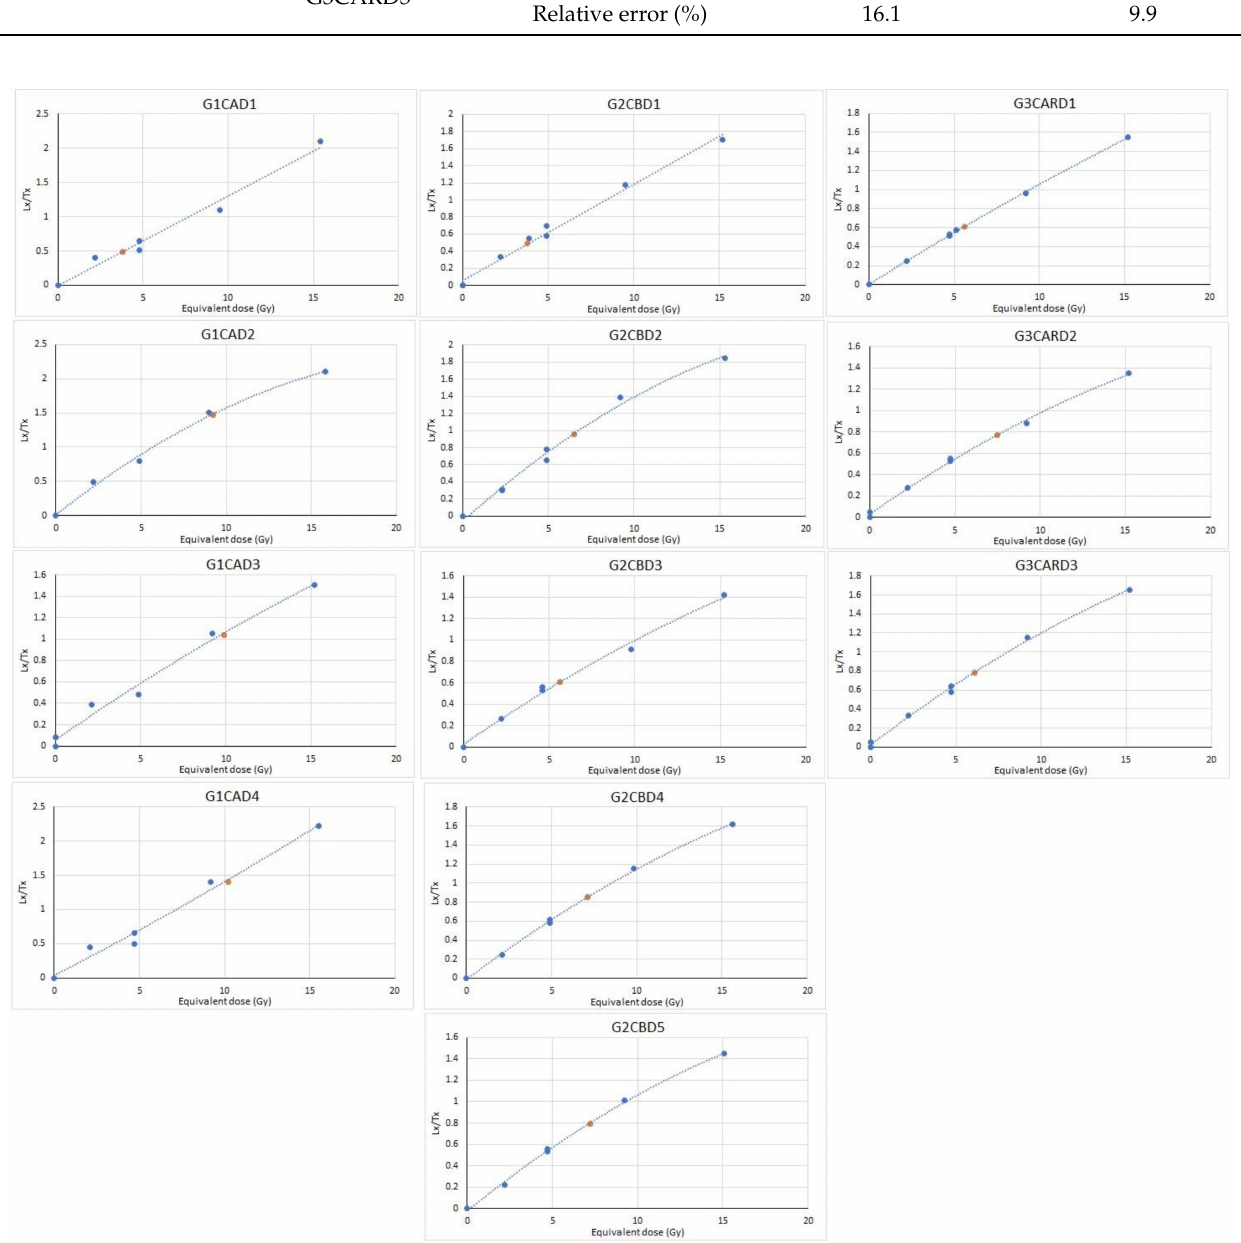
Figure 8. Typical OSL dose response curve curves. The y -axis shows the ratios obtained for each of these artificial doses (Lx/Tx) and for the natural sample